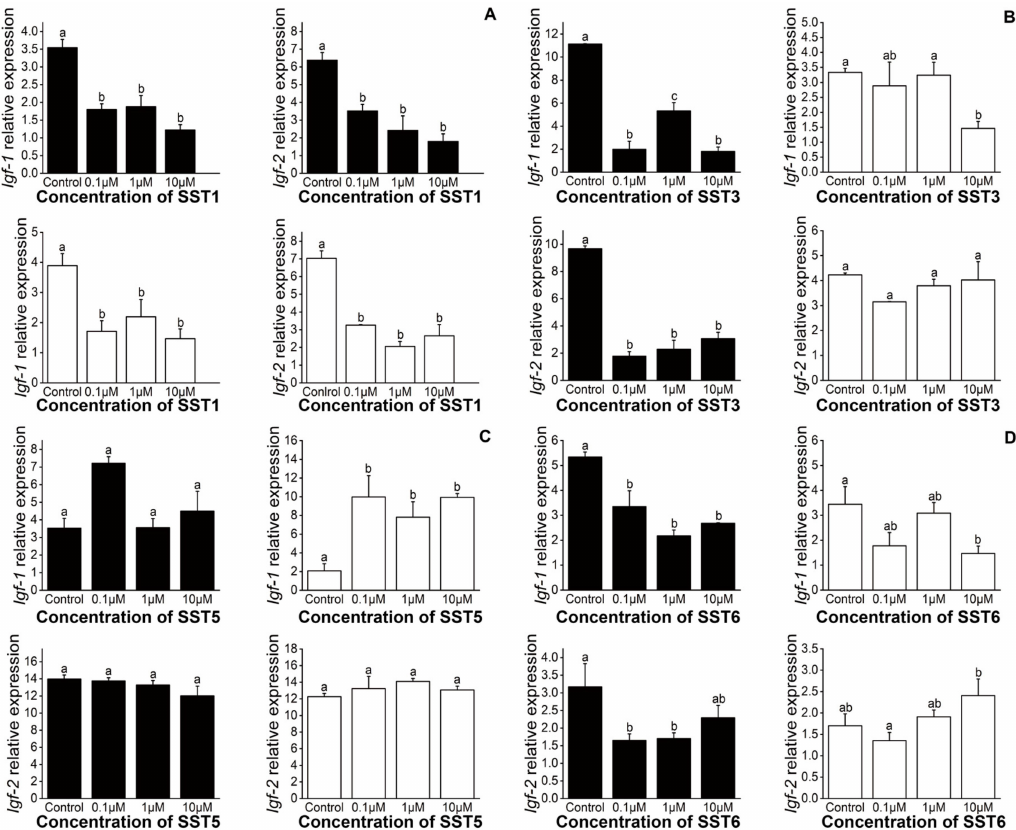
Figure 5. E ff ects of di ff erent concentrations and in vitro incubation times of SST1 ( A ), SST3 ( B ), SST5 ( C ), and SST6 ( D ) on the expression of Igf-1 and Igf-2 in liver. Black bars represent incubations for 3 h and incubation for 6 h in white bars. Data are presented as mean ± SEM (n = 3). Significant di ff erences at P < 0.05 were labeled with di ff erent